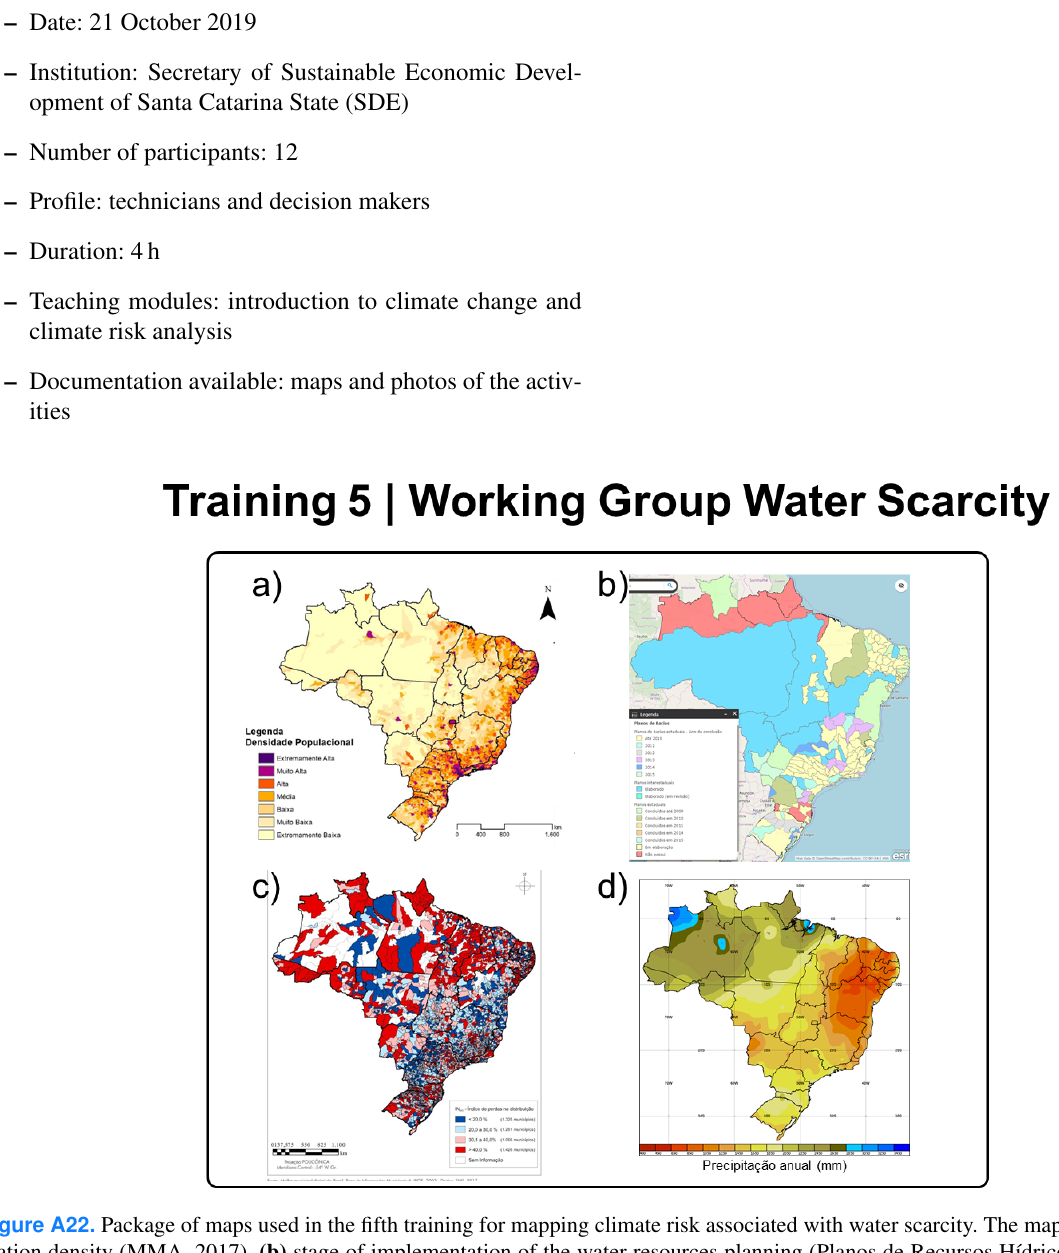
Geosci. Commun., 4, 527–554,